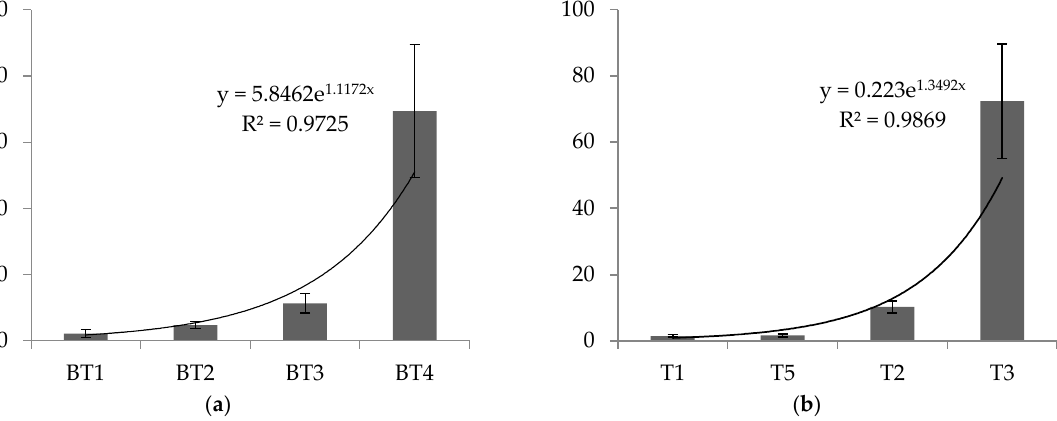
Figure 7. The stocks of organic matter in organic soil horizons: ( a ) background soils, and ( b ) quarry soils, t ha −1 . The error bars represent standard deviation. All abbreviations are explained at Table